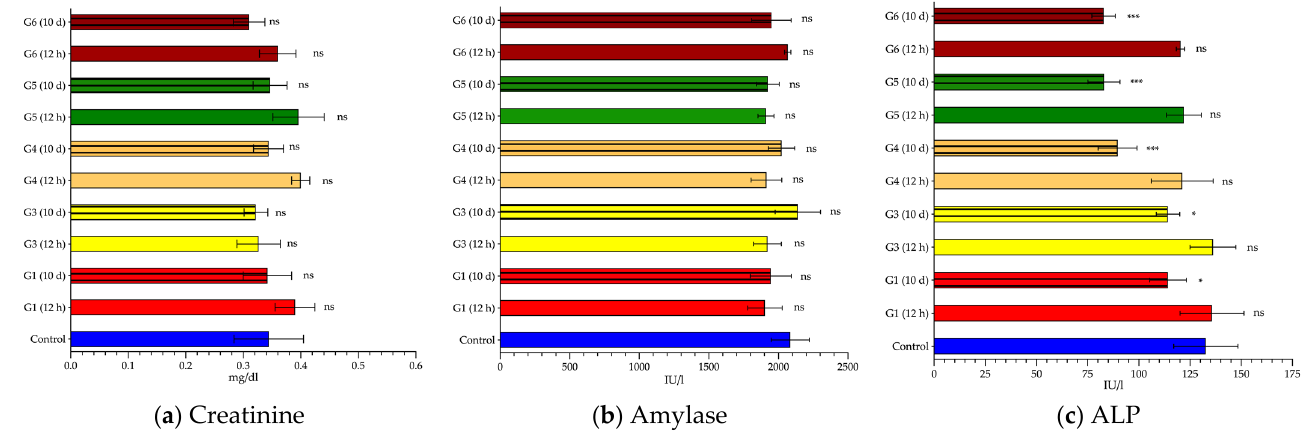
Figure 6. Serum enzyme values specific to other systems and/or organs. Creatinine ( a ), amylase ( b ), and alkaline phosphatase (ALP) ( c ) mean values (and standard deviation) measured in blood samples collected 12 h (smooth pattern) or 10 days (striped pattern) from control (blue) or alternating magnetic field (AMF)-exposed rats: 14 kA/m and 591 kHz (G1, red); 16 kA/m and 591 kHz (G3, yellow); 13.7 kA/m and 700 kHz (G4, orange); 14.4 kA/m and 774 kHz (G5, green); 11.2 kA/m and 856 kHz (G6, garnet). For creatinine, values are expressed in milligrams per deciliter (mg/dL), and both for amylase and ALP, figures are expressed in international units per liter (IU/L). Statistical significance is shown compared to the control group values (*: p < 0.05; ***: p < 0.001; ns: p >